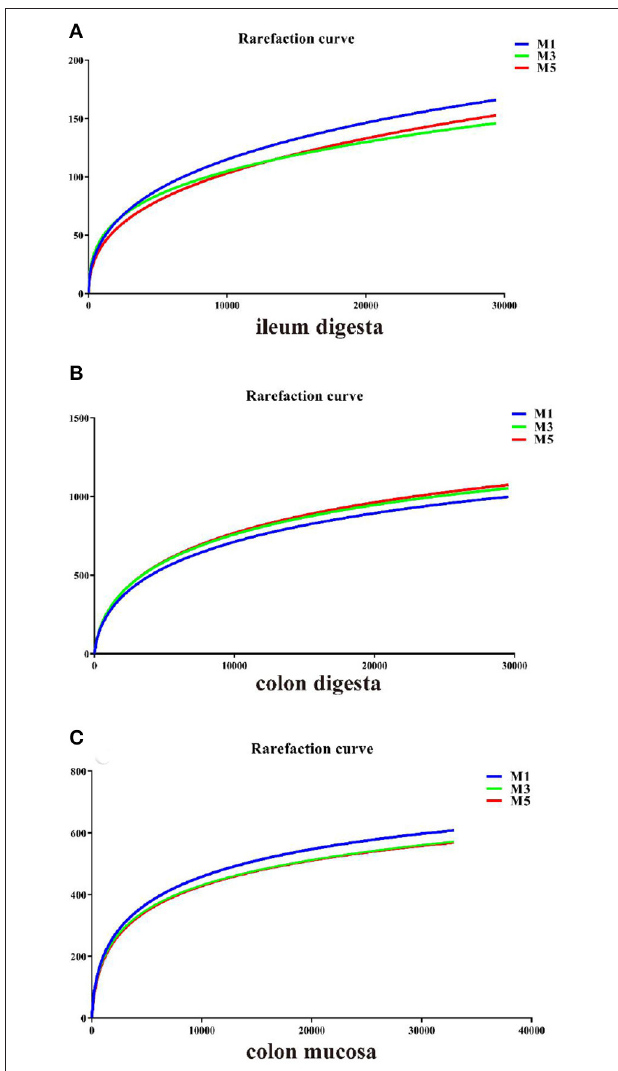
FIGURE 1 | Rarefaction curves comparing the number of sequences with the number of operational taxonomic units (OTUs) found in the 16S rRNA gene libraries from microbiota in the ileal digesta, colonic digesta, and colon mucosa of pigs in three groups. M1, mean of eight repetitions in pigs fed one meal daily; M3, mean of eight repetitions in pigs fed three meals daily; M5, mean of eight repetitions in pigs fed five meals